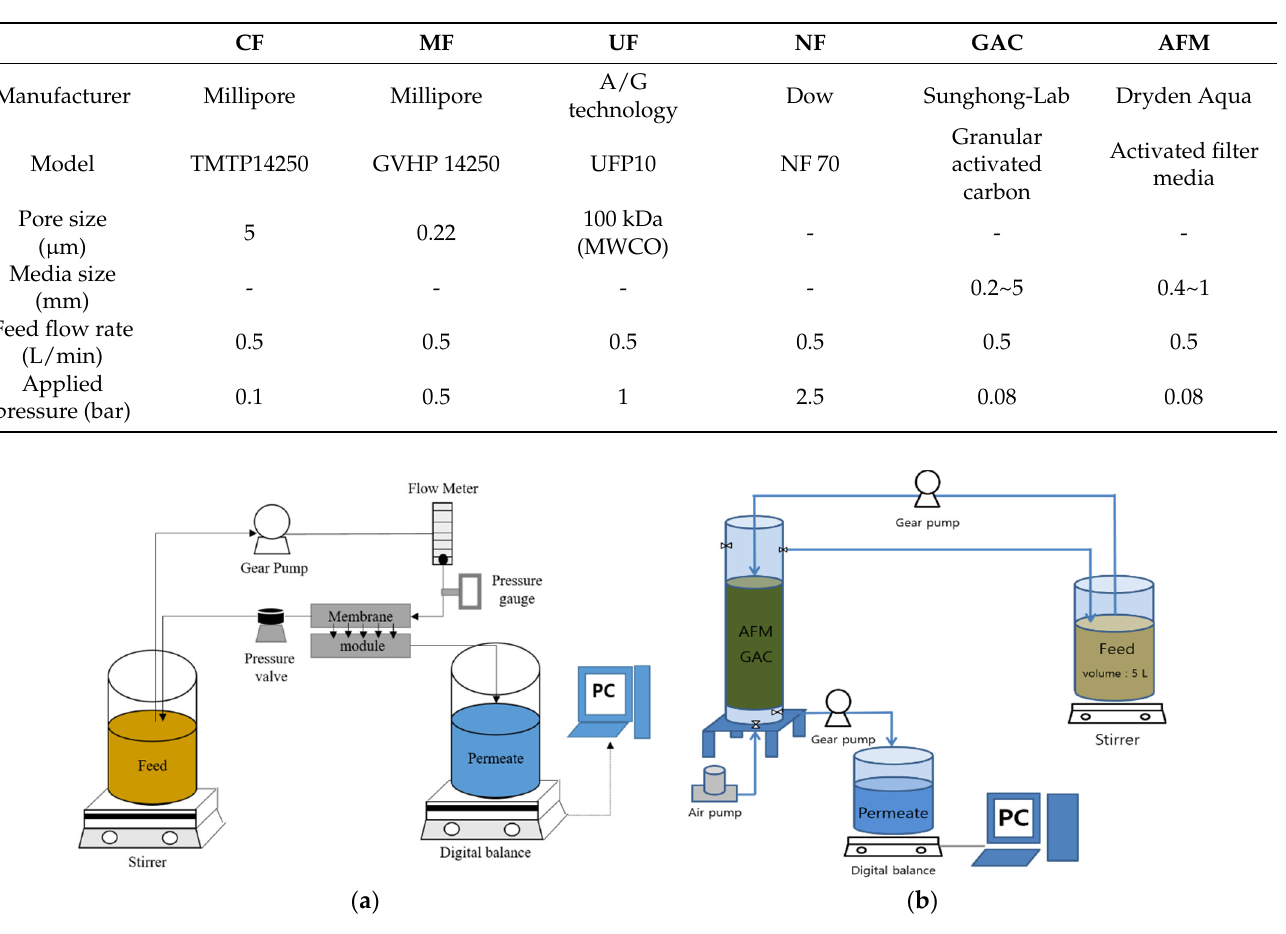
Figure 3. Schematic diagram of bench-scale pretreatment device: ( a ) CF/MF/UF/NF; and ( b ) AFM/GAC.